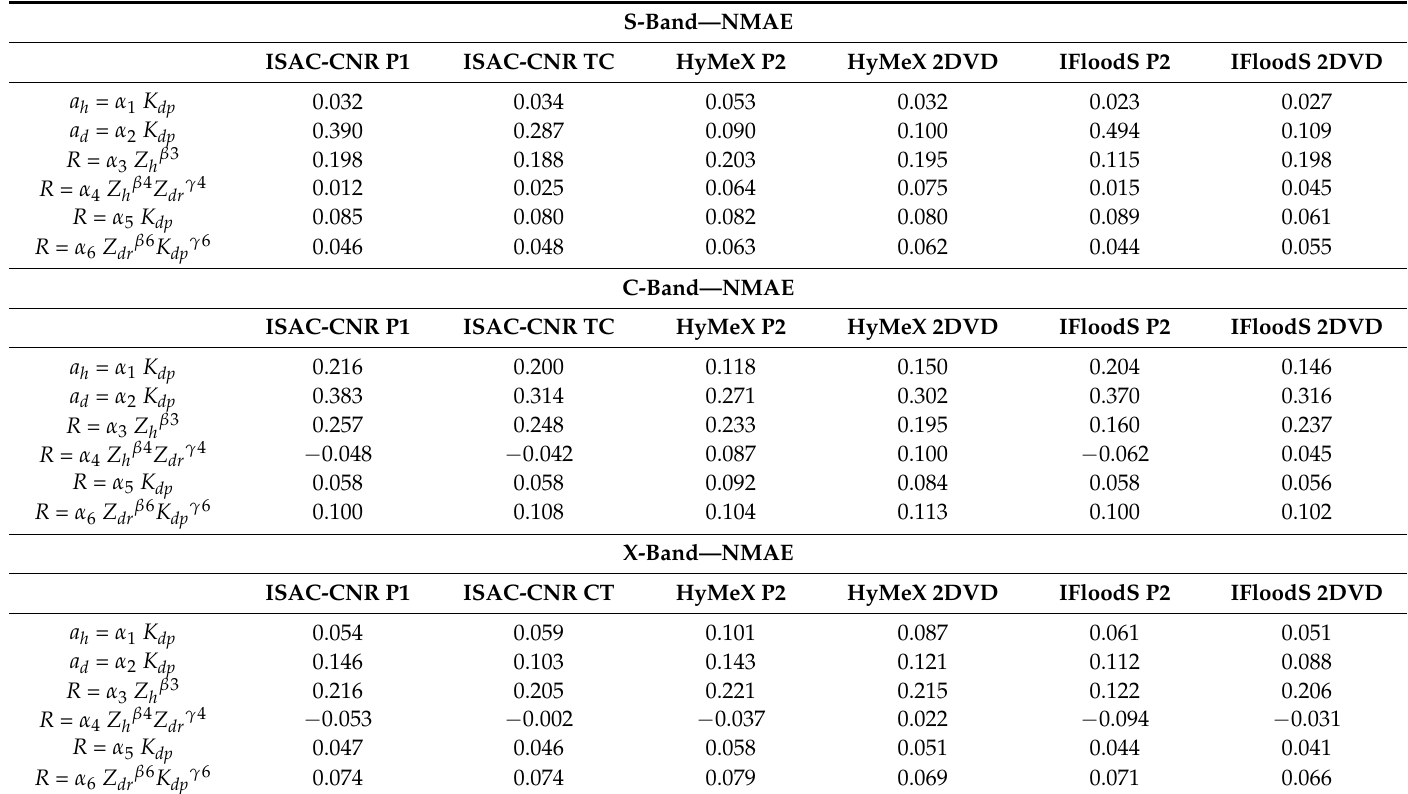
Table 2. For each dataset and for each band, the table provides the variation of the NMAE estimator (namely, differences between NMAE obtained following the 1-min DRM approach and the SIFT approach) obtained for the different weather radar algorithms computed considering 1-min samples and the SIFT approach. Positive values indicate a reduction of the NMAE when the SIFT approach is